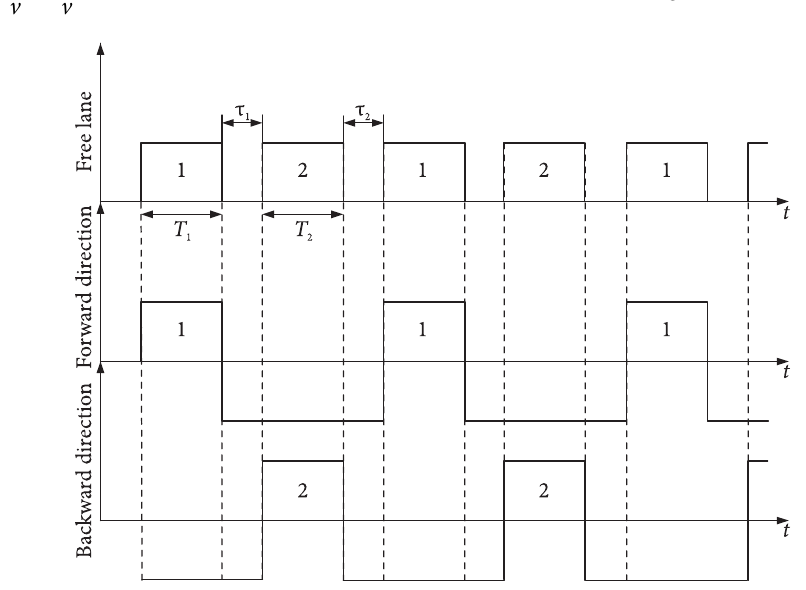
Fig. 6. Th e general case of time diagrams for the traffi c regulation at the construction works zone of a two-way